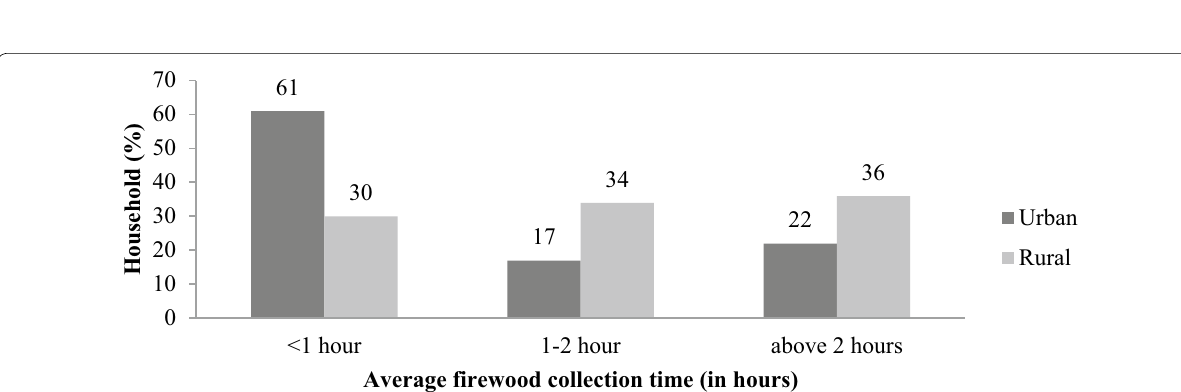
Fig. 2 Classification of Ethiopian households by firewood collection time per round trip Source: Author’s compilation based on Central Statistical Agency